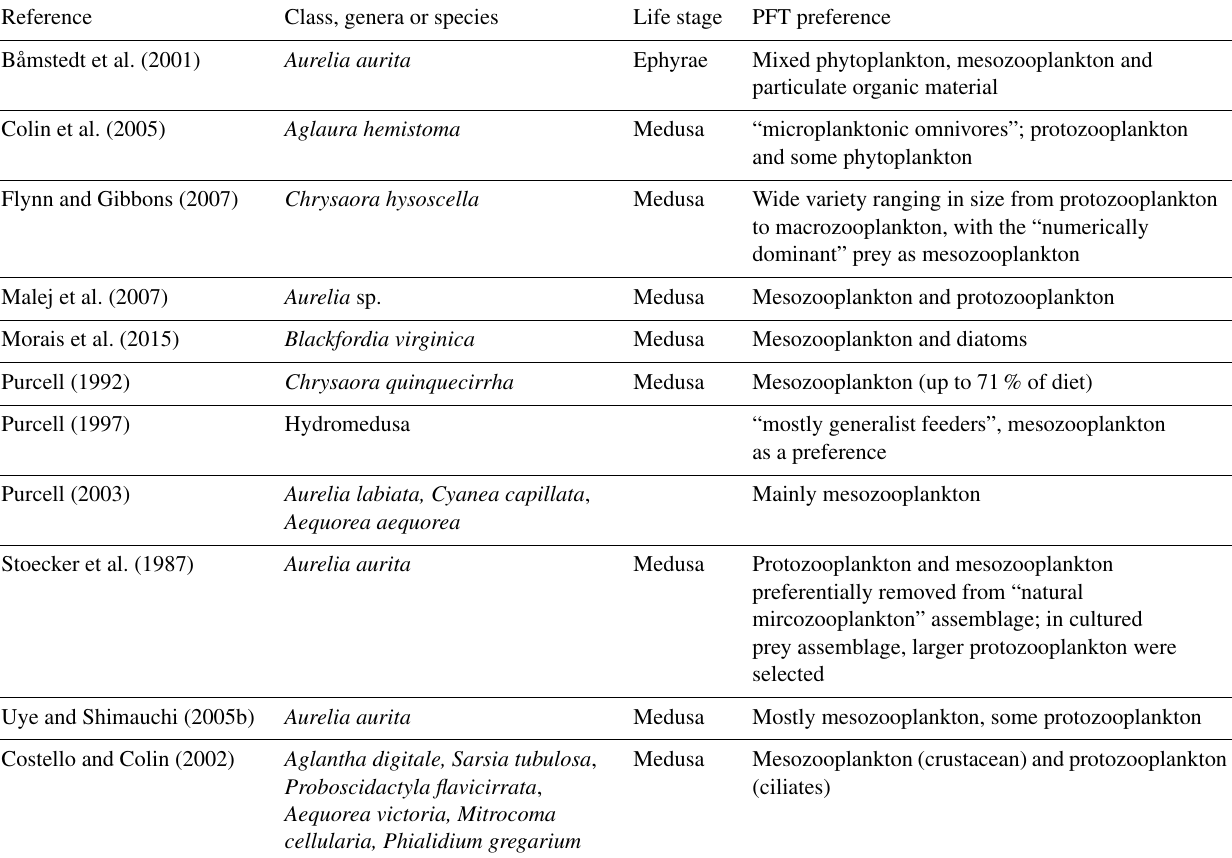
Table A3. Sources and metadata for jellyfish grazing preferences, including references with associated species, life stage and preference for prey (categorised into PFTs) with any notable phrases used to inform the grazing of jellyfish in